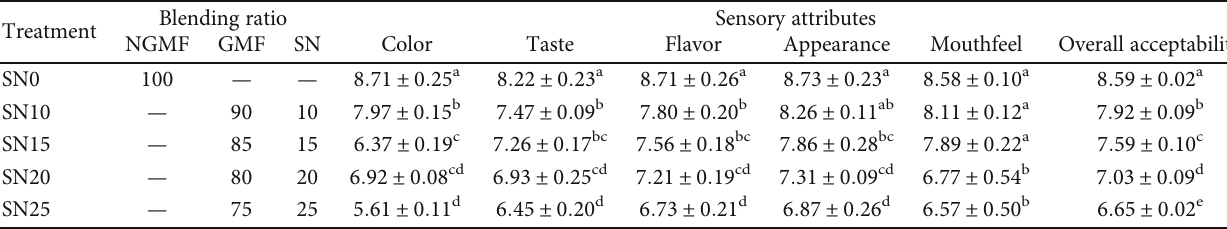
Table 4: Means 1,2 of sensory acceptability scores of the fl atbread developed from stinging nettle and maize fl our performed at laboratory level. Blending Treatment